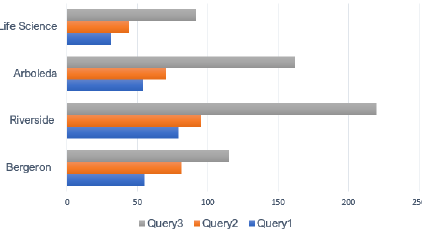
Figure 20. Cypher queries evaluations (in